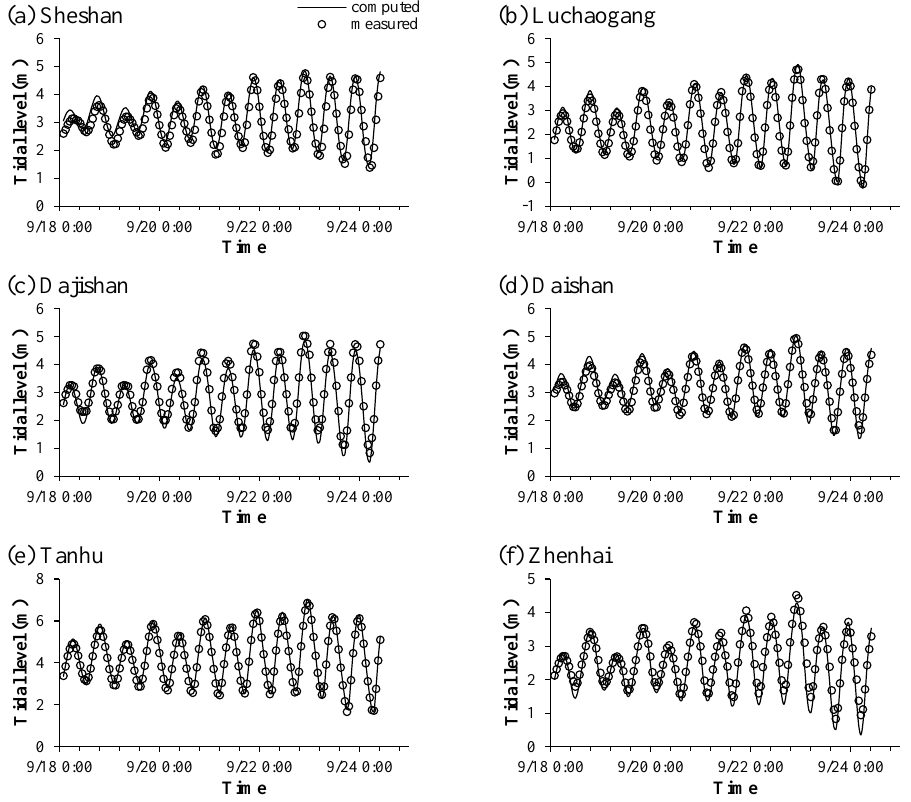
7 of 21 Figure 3. Wind process demonstrating the manifestation of Typhoon Fongwong at Sheshan station from 19 to 27 September 2014. The upper vectors are the wind speed and direction change phenom- enon. Water level measurements from tidal gauges at Sheshan, Luchaogang, Dajishan, Daishan, Tanhu and Zhenhai (Figure 1) in the study area are used to verify the modeled water elevation affected by Typhoon Fongwong. As shown in Figure 4, the comparisons of the time series of computed and observed water elevation at six tidal gauges from 18– 24 September in 2014 show good agreements in both magnitudes and phases. Figure 5 is the difference between the measured tide and astronomic tide, which shows a significant increase around 23 September. The surges during the typhoon period are well repro- duced, which indicates the effects of the wind on water level that was captured by the model. The period of current velocity simulation for validation spanned from 28 February 2014 to 1 March 2014 at three stations (positions shown in Figure 1). The computed current profile and direction are also well matched with the measured data, and Figure 6 shows the comparison of the surface and bottom current velocity and direction at one selected